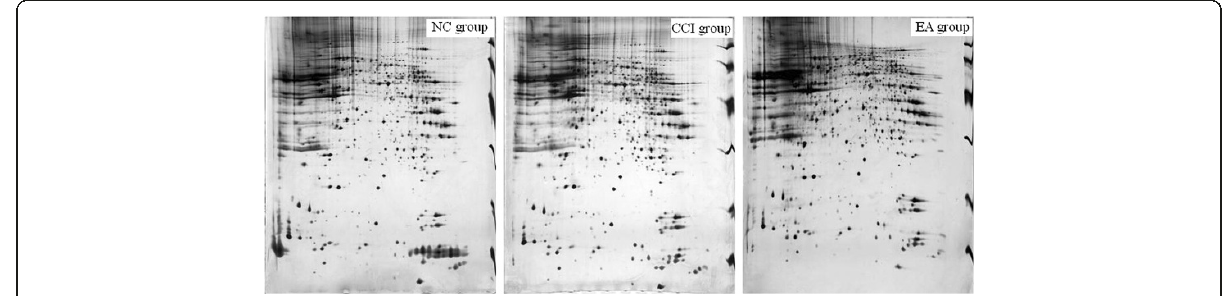
Figure 2 Hippocampal tissue protein profiles obtained with silver stained gels from the three groups.